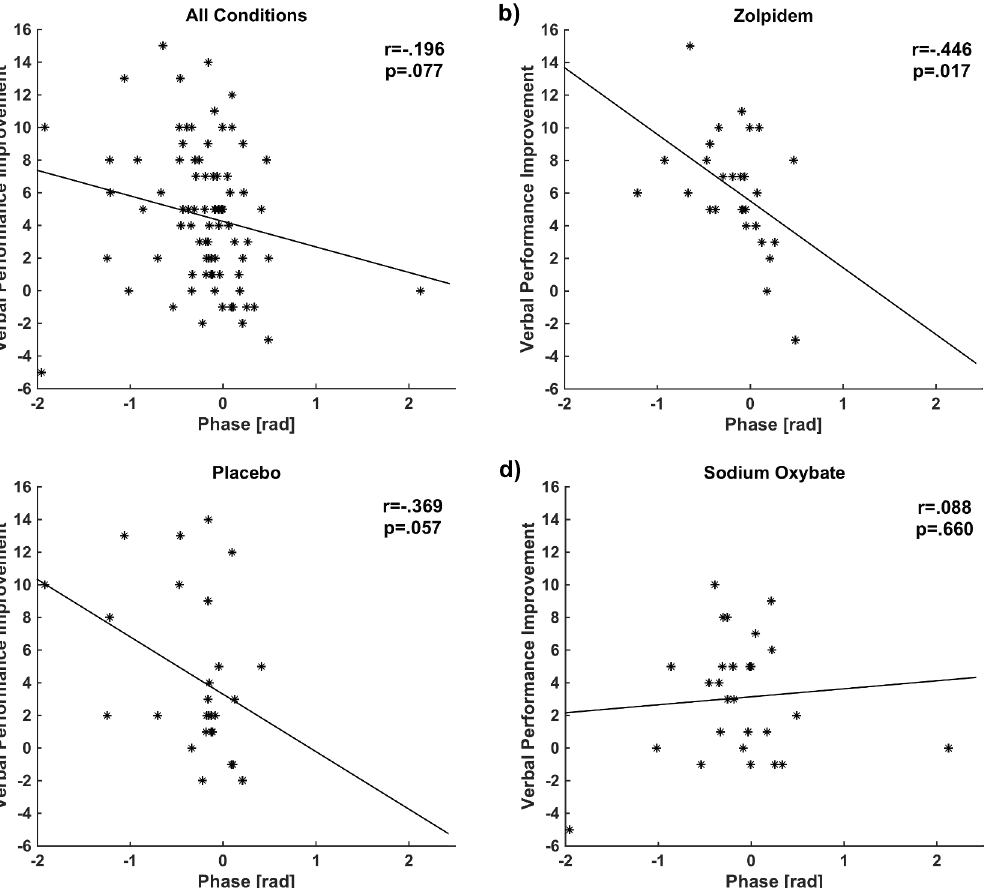
Fig 3. Memory performance improvement and phase-amplitude timing: SO phase at spindle peak was correlated with memory improvement in zolpidem and placebo conditions suggesting a general mechanism of memory formation. This relationship was not observed in sodium oxybate, which showed the worst performance. Phase value of each subject corresponds to the average value over all spindle/SO complexes in that subject. (a) : All conditions, (b): zolpidem, (c): placebo (d): sodium oxybate.